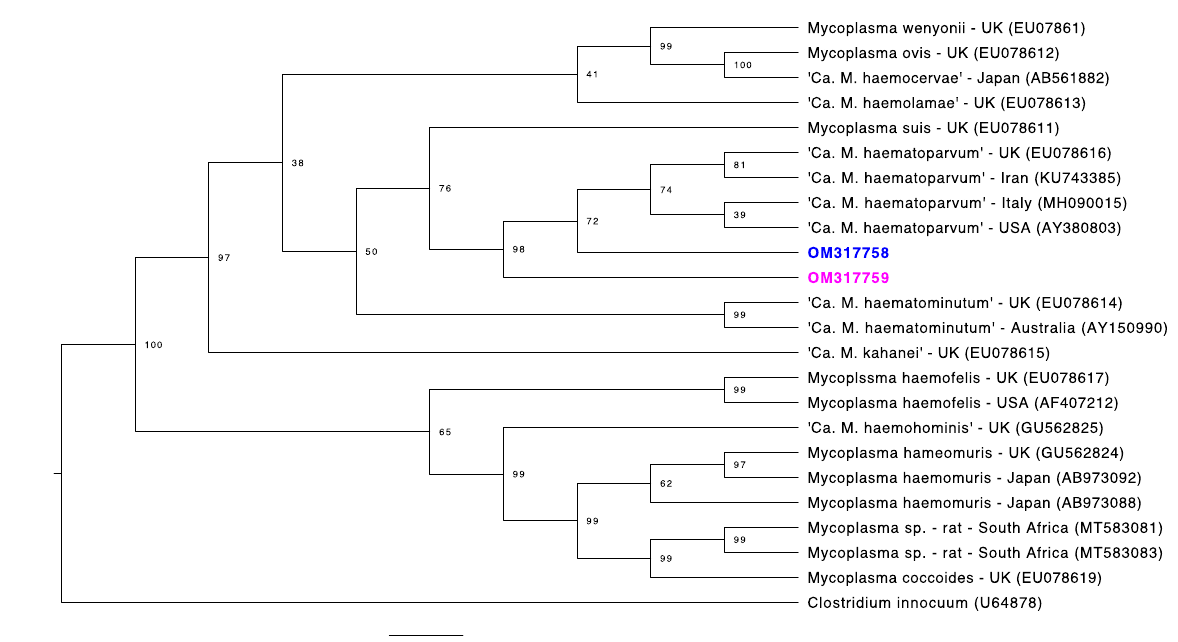
Figure 3. Phylogenetic tree based on partial RNAse P gene fragments of Mycoplasma sp. Tree was constructed by Bayesian Inference and a sequence from Clostridium innocuum (U64878) was used as outgroup. Sequences obtained in the present study are highlighted in colors: the sequence that fit in Ca1 by the 16S rRNA phylogeny is highlighted in pink. The sequence that fit in Ca2 by the 16S rRNA phylogeny is highlighted in blue.